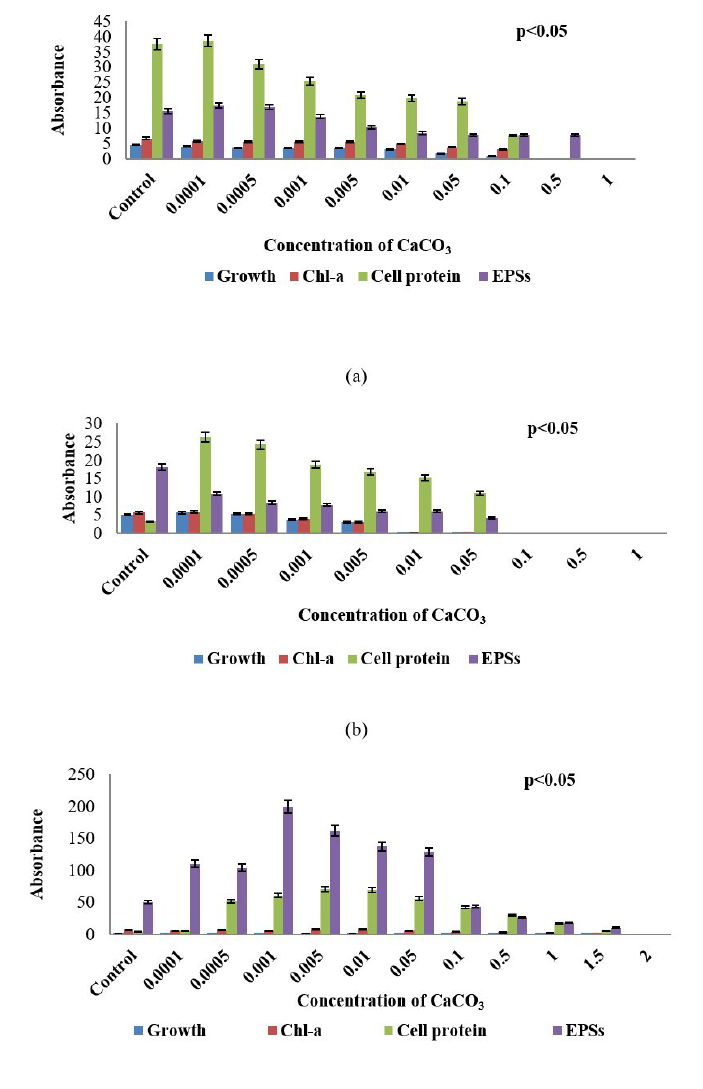
Fig. 3. Growth response, chlorophyll – a , carotenoid, soluble cell-protein, and extracellular polysaccharides content of three sub-aerial cyanobacteria, (a) Scytonema coactile (limestone, Gupteswar cave), (b) Scytonema geitleri (lime-washed wall, Building) and (c) Lyngbya aerugineo-coerulea (Stone carving, Bhaskareswar Temple) upon treatment to different concentrations of Calcium carbonate. Cultures were incubated at 25 ± 1°C under 7.5 W/m² light intensity up to 15